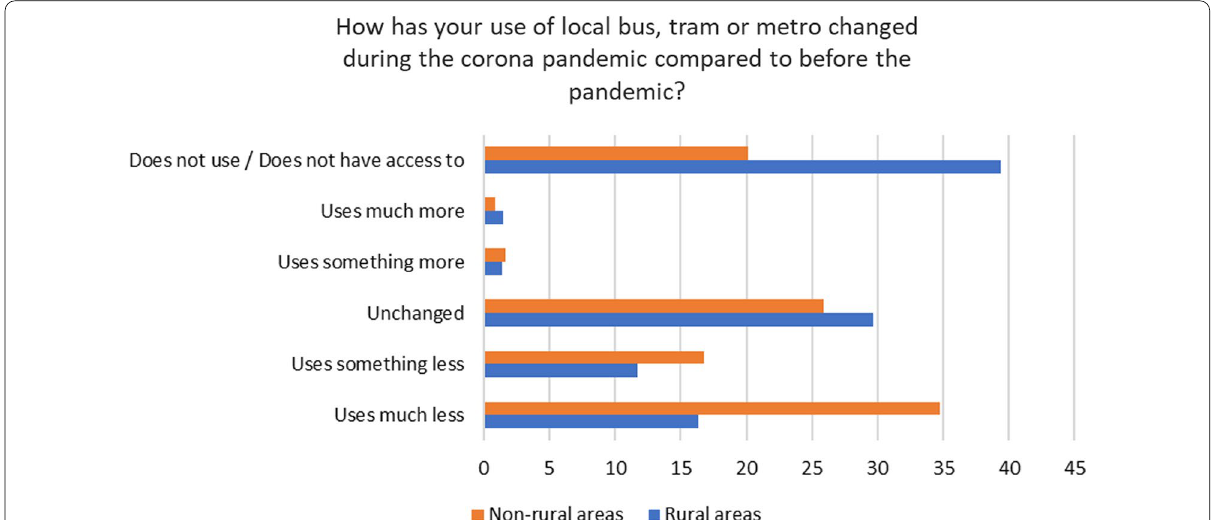
“Before the COVID-19 pandemic, rural areas were already facing huge challenges connecting those within the community to each other, but the virus has forced places to radically adapt.“ (https://www.ageing- better.org.uk/stories/reworking-rural- community-bus-during-covid-19-pandemic) Huntly Community Minibus,